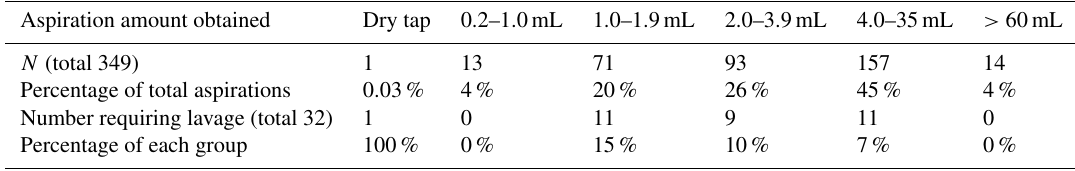
Table 1. Fluid aspiration amounts with percentage of total aspirations and lavage percentage.